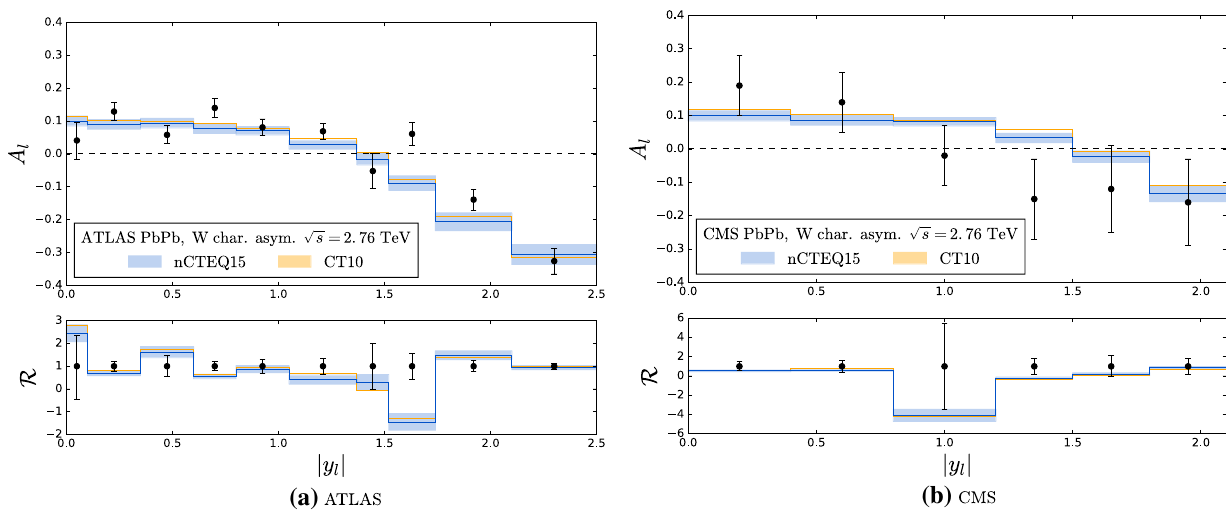
√ s = 2 . 76TeV as measured by the ATLAS and CMS collaborations.